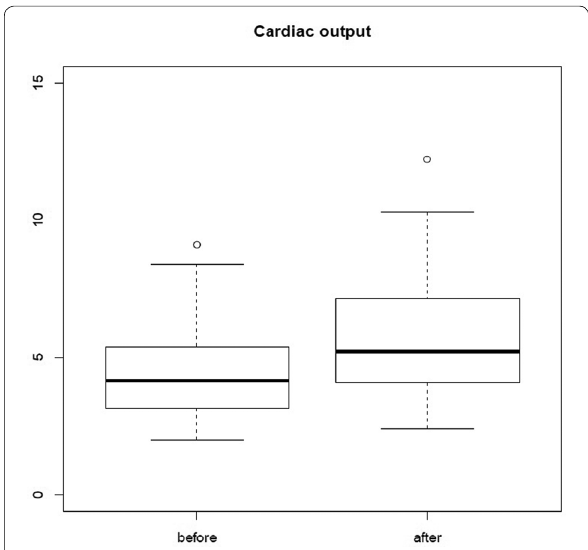
Fig. 3 Significant increase of absolute value in GLS: versus 18.4 4.5% ( p < − ±